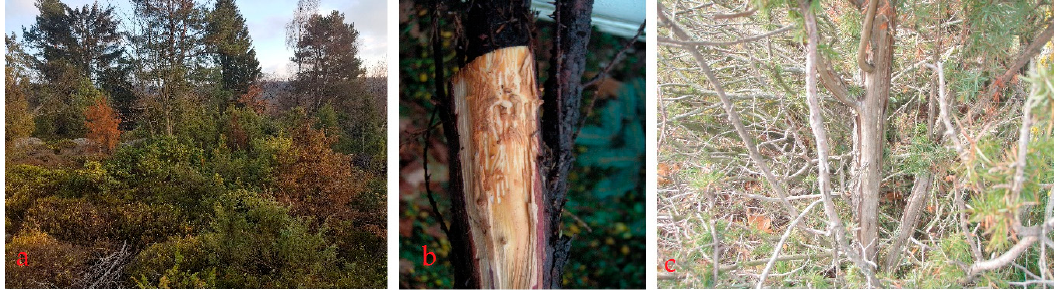
Figure 2. Dying junipers ( Juniperus communis ) in the Rajché ř ov locality ( a , the dying trees are red), galleries of Phloeosinus aubei on J. communis in the Mariánské Lázn ě locality ( b ), and a juniper tree damaged by antler rubbing in the Vrbi č ka locality ( c ).